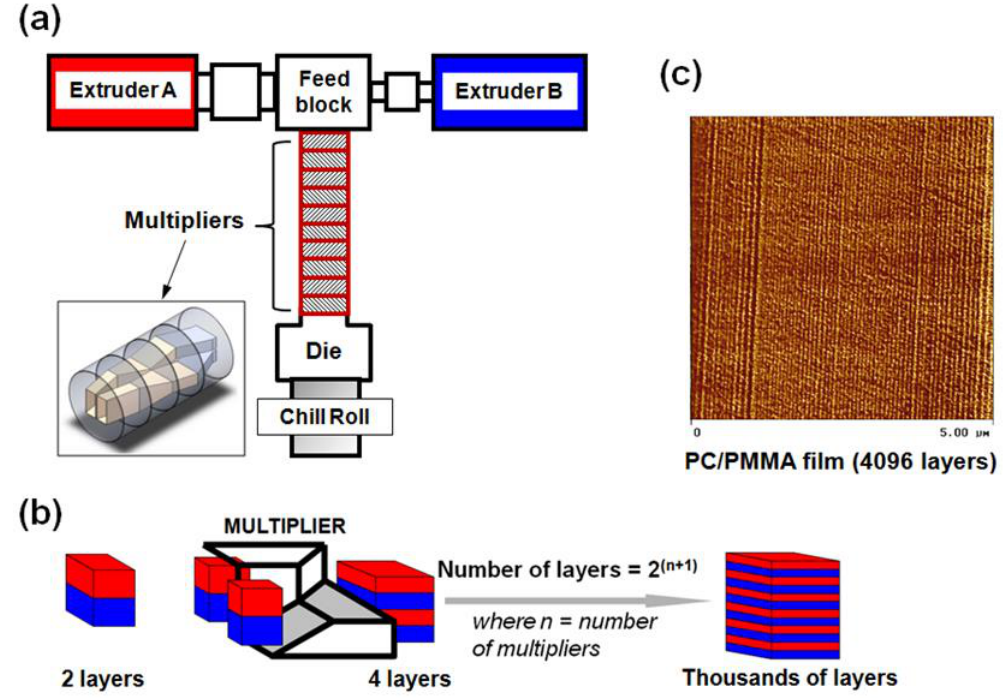
Figure 11. Schematic illustrations of ( a ) multilayer coextrusion process with two polymeric components with a specific scheme of multiplier element used in our laboratory, and ( b ) general layer multiplication concept schematic of the layer multiplication by cutting, spreading and recombining. ( c ) AFM phase image showing the cross-section of a 4096 layers PC/PMMA (50/50) film as an example for coextruded multilayered polymers. Reprinted from publication [67]. Copyright 2020, with the permission from Wiley. (A color version of this figure can be viewed online).